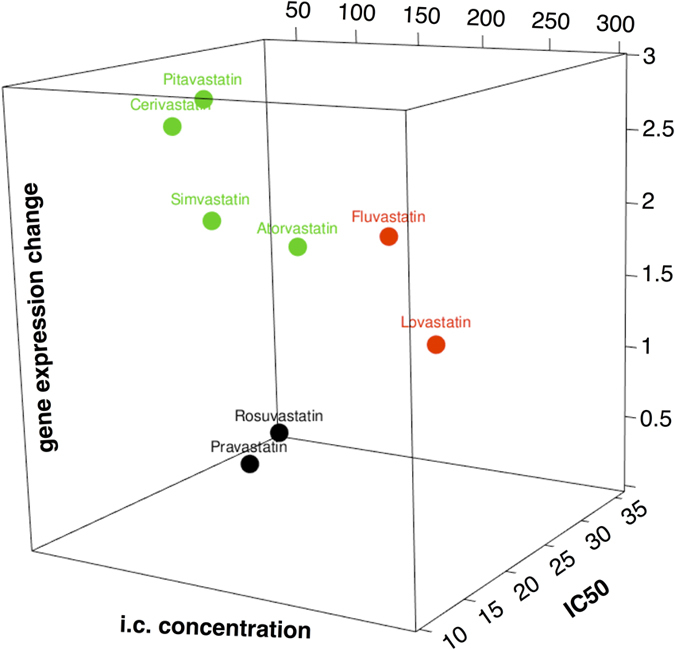
The relationships among the lipophilicity, intracellular concentrations of individual statins, and their impact the gene expression change.Statins were clustered according to their lipophilicity51 into 3 groups: hydrophilic (black color), lipophilic (red color), and highly lipophilic (green color). IC50 is expressed in μM, intracellular concentration (i.c.) of statins in nmol/100 000 cells, and gene expression change as log10(#DEG + 1).